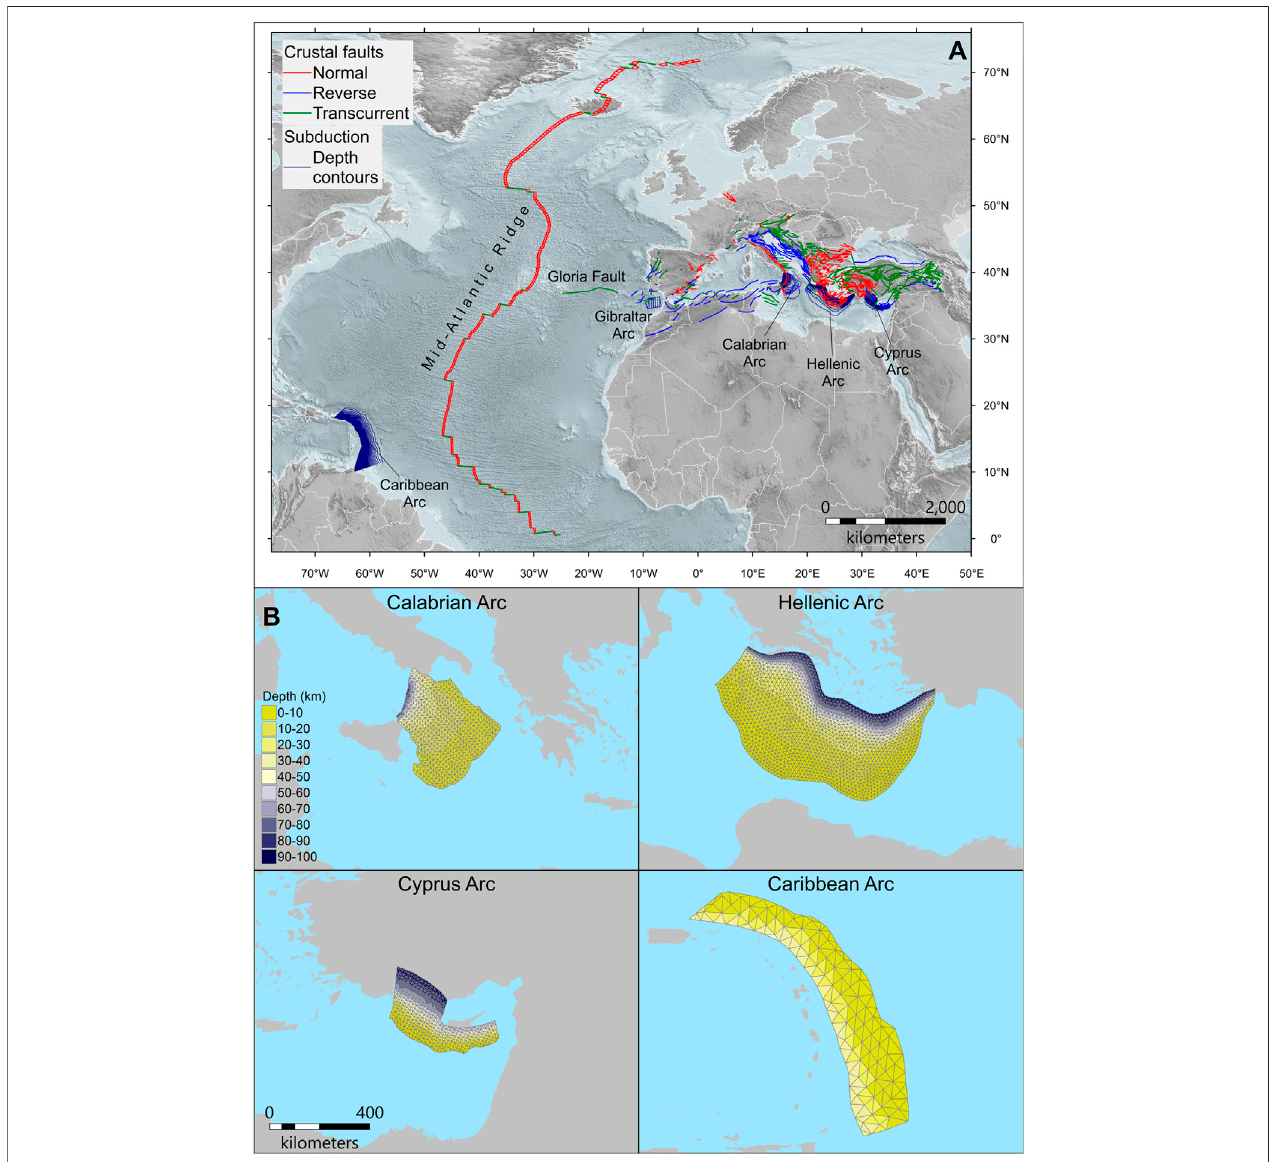
FIGURE 5 | (A) Map of the fault datasets. The primary sources of information for the fault geometry and kinematics are as follows: the European database of Seismogenic Faults (EDSF) (Basili et al., 2013a; Woessner et al., 2015); the database of Individual Seismogenic Sources, DISS version 3.2.1 (DISS Working Group, 2018), used to replace EDSF in the central Mediterranean; the global plate boundary model (Bird, 2003) as a reference for the Mid-Atlantic Ridge and the Gloria fault. All crustal faults are color-coded based on their mechanism. The geometry of the three Mediterranean slabs was initially derived from the European database of Seismogenic Faults (EDSF) (Basili et al., 2013a; Woessner et al., 2015) and then modi fi ed according to newer data where available. In particular, the Calabrian Arc was entirely replaced by a recent model (Maesano et al., 2017) derived from the interpretation of a dense network of seismic re fl ection pro fi les integrated with the analysis of the seismicity distribution at depth. The Hellenic Arc is the same as that in EDSF, but we veri fi ed its consistency with recent works (Sodoudi et al., 2015; Sachpazi et al., 2016).TheCyprusArcwasslightlymodi fi edinconsiderationofresultsfromrecentworks(Bak ı rc ı etal.,2012;Salaünetal.,2012;Sellieretal.,2013a;Sellieretal.,2013b; Howelletal.,2017)thatarebasedonseismic re fl ection pro fi lesand tomographicand seismologicaldataand constrainthegeometry ofthewesternpart oftheslab.The geometry of the Caribbean slab was entirely derived from an early version of the Slab two model (Hayes et al., 2018), provided as a courtesy by G. Hayes. All slab geometries are represented with depth contours, except for the Gibraltar Arc, which is represented by a sketch to show its location only. Topo-bathymetry is from the ETOPO1 Global Relief Model (NOAA, 2009; Amante and Eakins, 2009). (B) Map views of the meshes used to discretize the subduction interfaces with color-coded depths.Thelocationsoftheseslabsareshowninpanel (A) .Themeshesarebuiltwithelementsizesetat ∼ 15 kmforthethreesubductioninterfacesintheMediterranean Sea, and ∼ 50 km for the subduction interface of the Caribbean Arc, using the Cubit mesh generator (Casarotti et al., 2008). For all subduction interfaces, strike and dip areimposedbythediscretization.Purethrustfaultingmechanism(rake90 ° )isassumedfortheCyprusArcbecauseoftherelativelysmallvariabilityofthedirectionofplate convergenceroughlynormaltostrike(Reilingeretal.,2006;Wdowinskietal.,2006),andtheCaribbeanArc,accordingtootherPSHAstudies(e.g.,Bozzonietal.,2011). Variable rakes are used for the Calabrian Arc and Hellenic Arc in agreement with the direction of plate convergence.